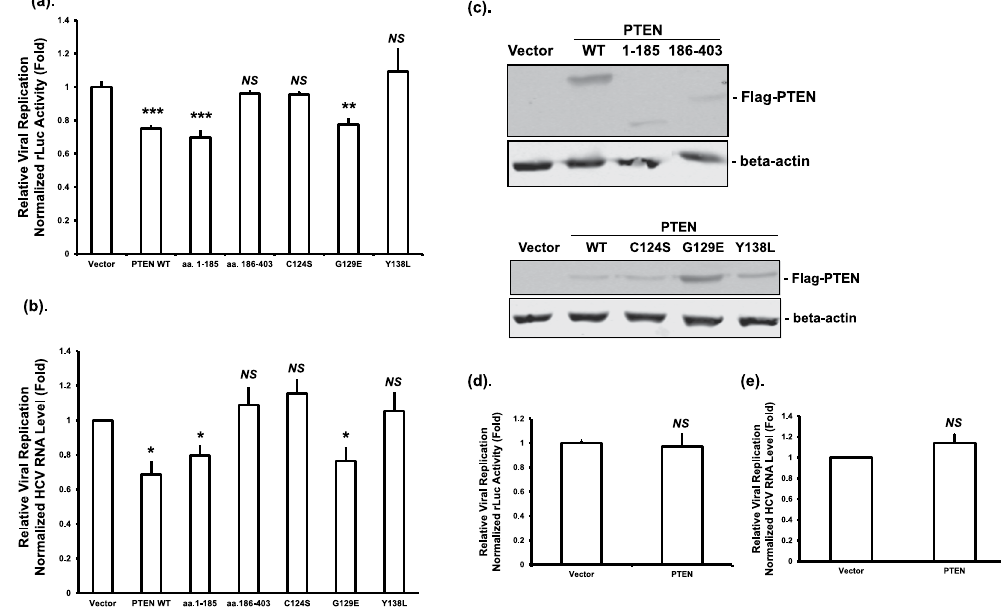
Figure 3. PTEN protein phosphatase activity is required for inhibition of HCV replication in HCV genomic replicon cells. ( a and b ) Huh-7 cells with an HCV-2a J6/JFH-1(p7-rLuc-2A) genomic replicon were transfected with plasmids expressing wild-type Flag-PTEN (PTEN WT), truncated mutants, phosphatase deficient mutants, or empty vector. Forty eight hours after transfection, luciferase activities ( a ) or HCV RNA levels ( b ) were determined. ( c ) The protein levels of PTEN and β -actin were determined by Western blotting using anti- PTEN and anti- β -actin antibodies, respectively. ( d and e ) Huh-7 cells with an HCV-2a JFH-1 rLuc subgenomic replicon were transfected with plasmid vector or PTEN expressing plasmid. Luciferase ( d ) and HCV RNA levels ( e ) were determined 48 hours after transfection. Data were expressed as fold changes relative to vector control; * p ≤ 0.05, ** p ≤ 0.01, *** p ≤ 0.001, or NS for not